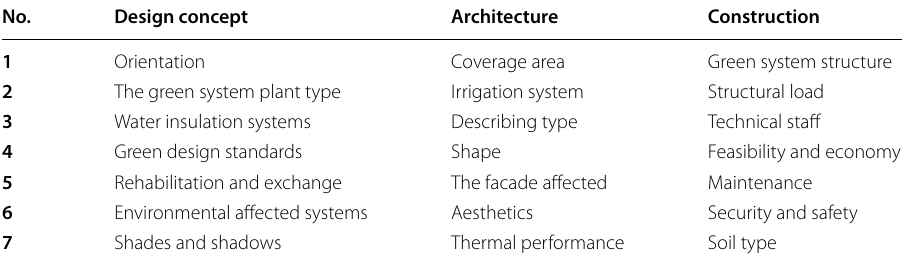
Table 1 Principles, considerations, features, and technical elements of SGWs [1, 6, 9, 11–17]